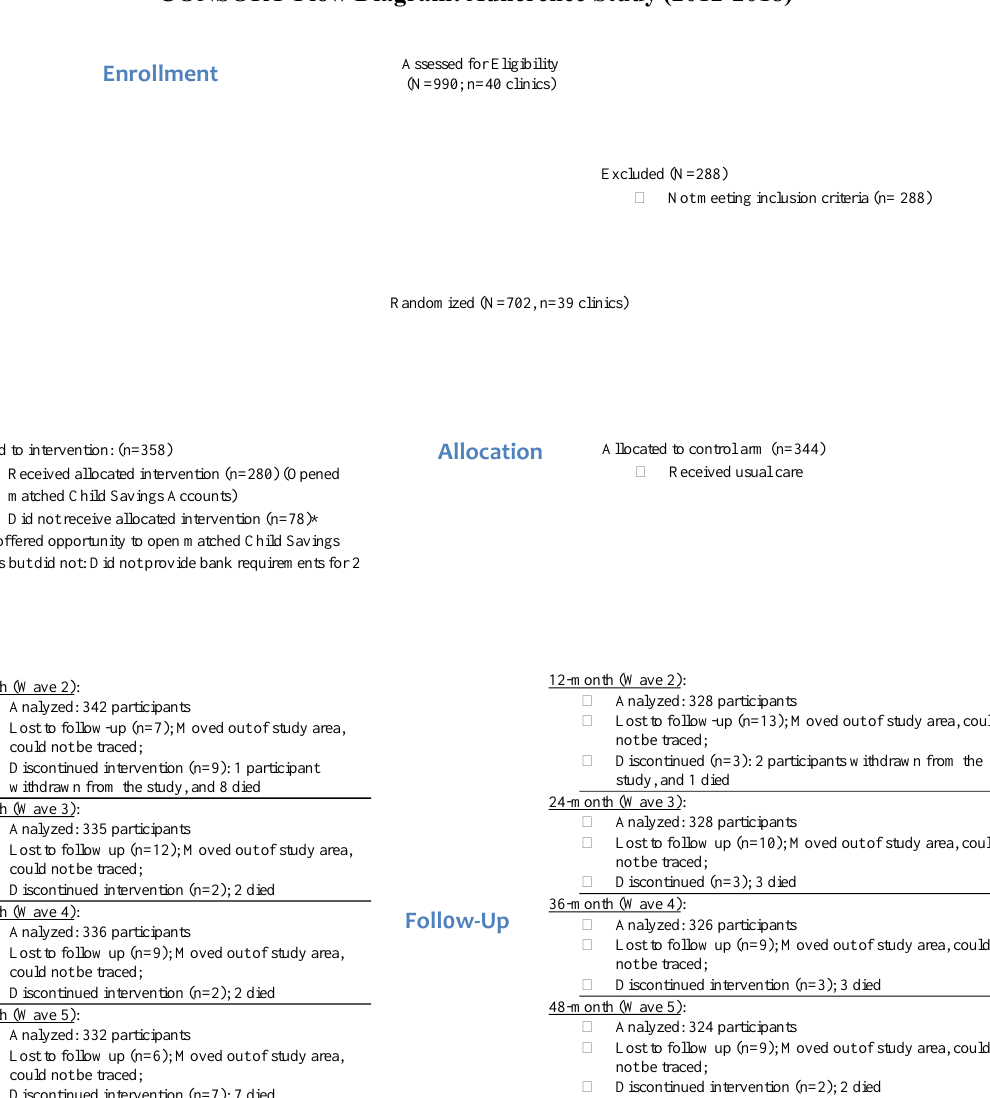
Figure A1: Consort Flow Diagram: Adherence Study (2012 – 2018) Figure A1. Consort Flow Diagram: Adherence Study